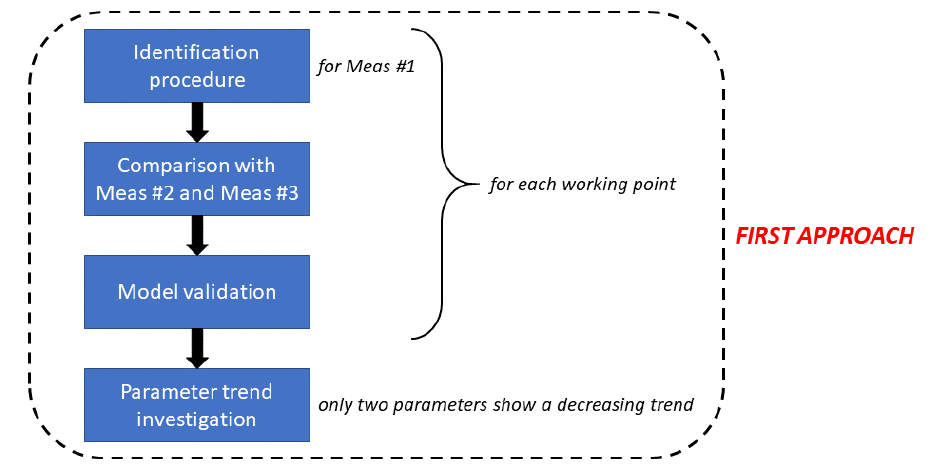
Figure 8. First approach